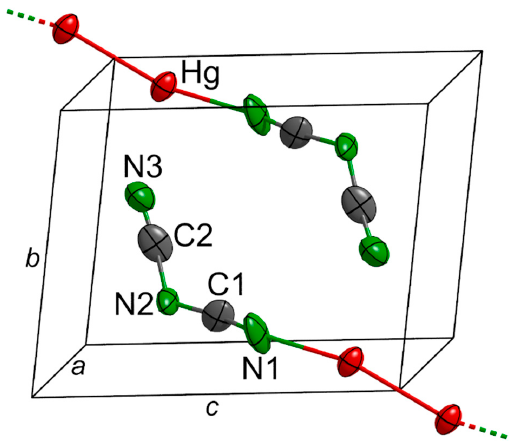
Figure 1. Crystal structure of Hg 2 [dca] 2 . The atomic displacement ellipsoids correspond to 90% probability using the refined anisotropic displacement parameters (ADPs).